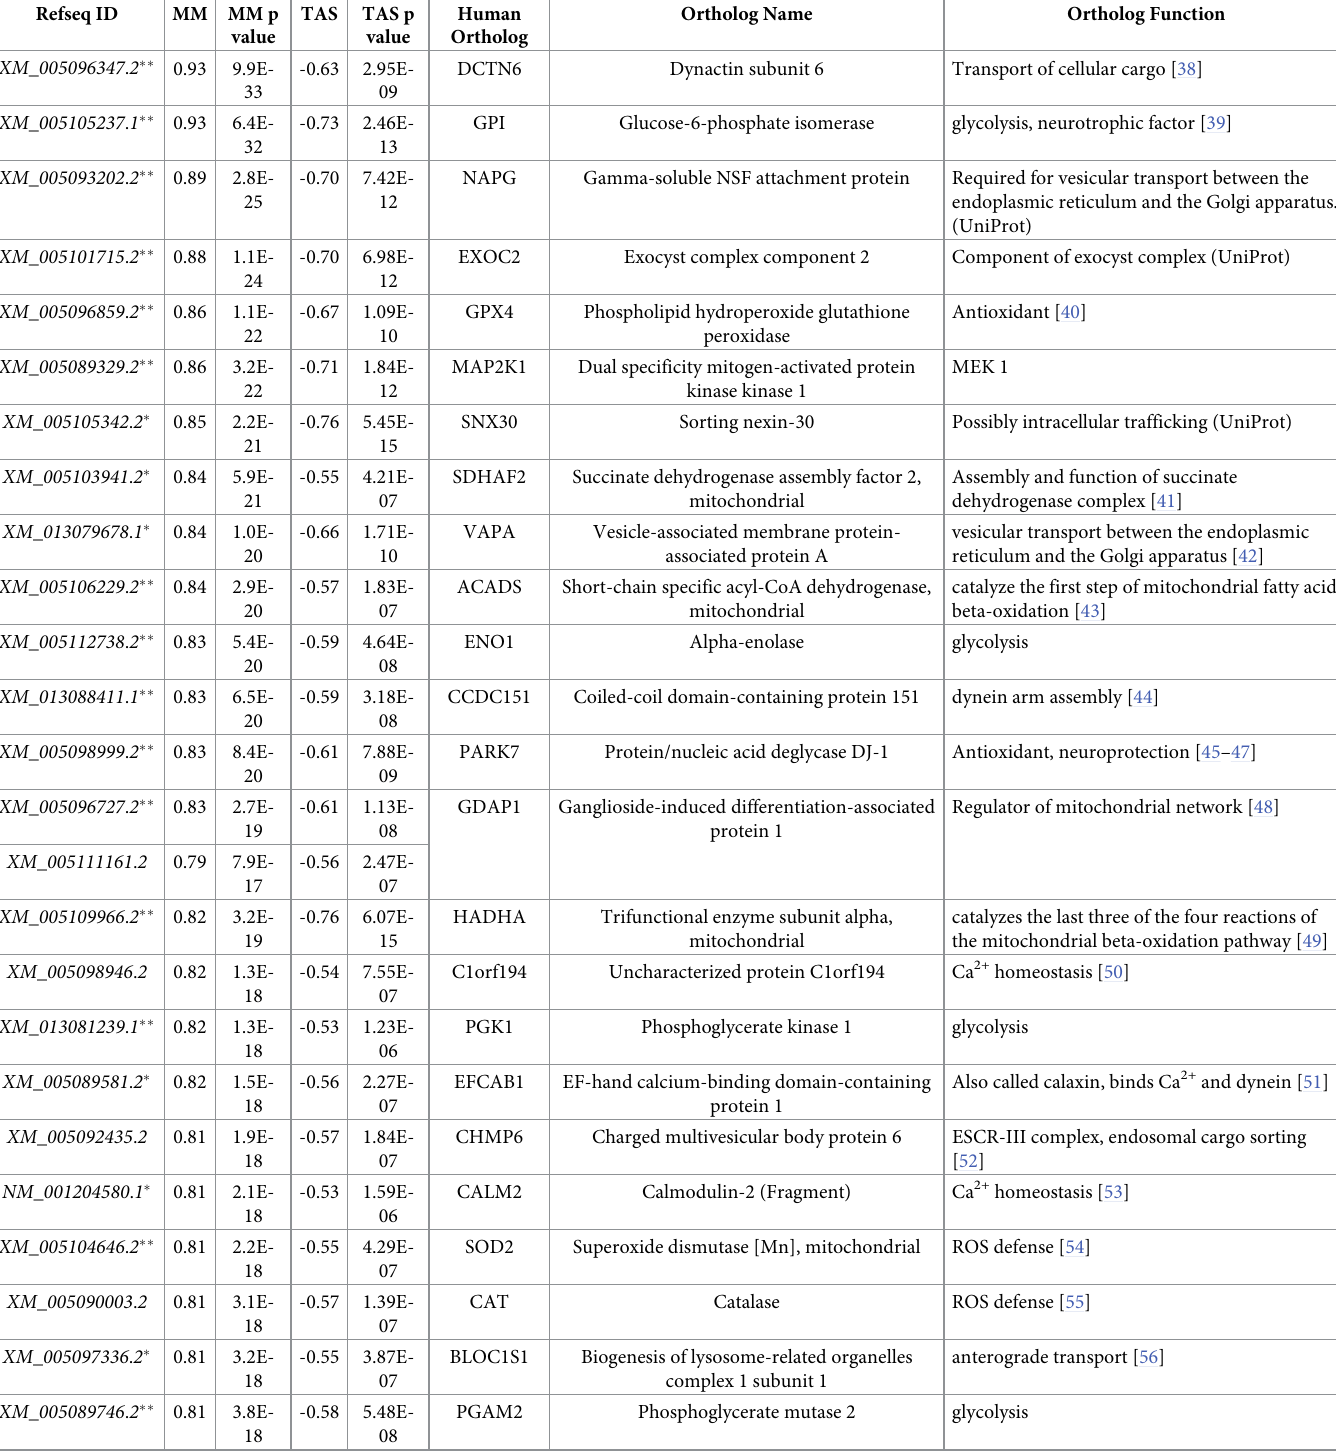
Table 2. Selection of transcripts with highest correlation to transcript co-expression module eigengene (module membership, MM) in the royalblue consensus mod- ule identified in Aplysia californica sensor neurons by WGCNA